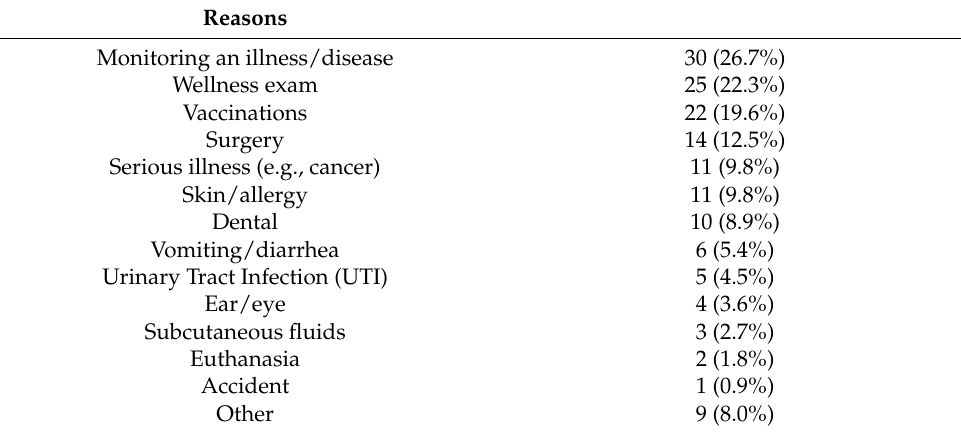
Table 5. Reasons for veterinary visits since the COVID